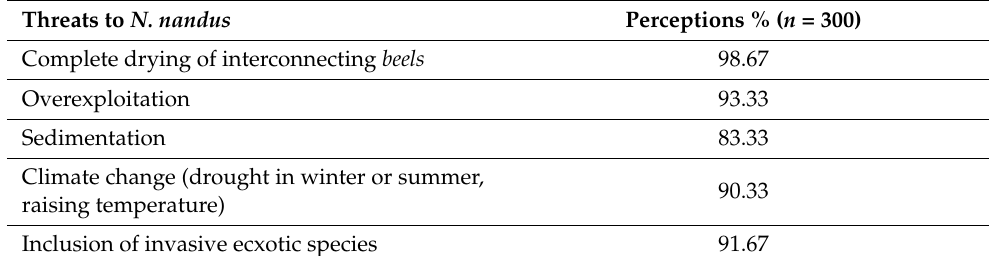
Table 2. Threats to N. nandus in the Kawadighi Haor.